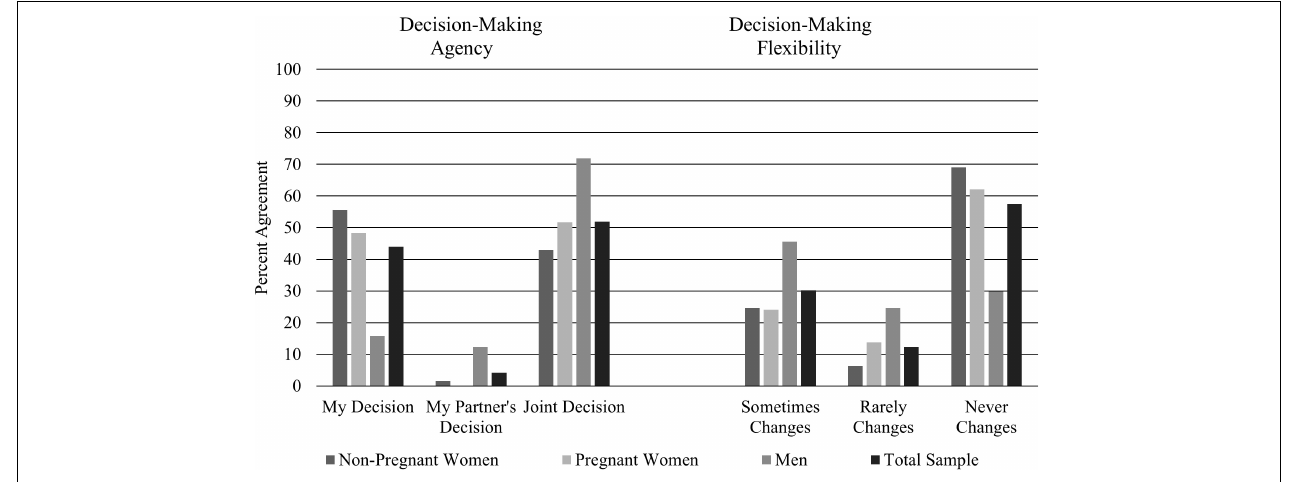
FIGURE 1 | Contraceptive decision-making agency and flexibility. Significant differences were observed between women and pregnant women and men for both decision-making agency and decision-making flexibility. Contraceptive decision-making agency was assessed with the question: “Whose decision is it to use birth control?” Contraceptive decision-making flexibility was assessed immediately after the contraceptive decision-making agency with the question: “Does the decision change depending on who the partner